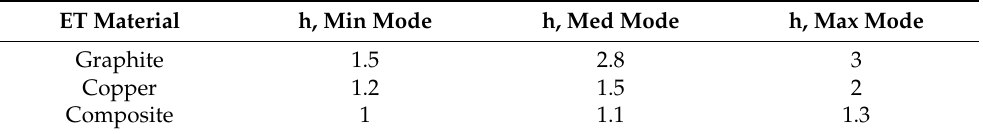
Figure 4. Uneven wear of ET during graphite EI processing in medium mode. Table 5. Uneven material removal during processing with heterogeneous ET in three modes, H,